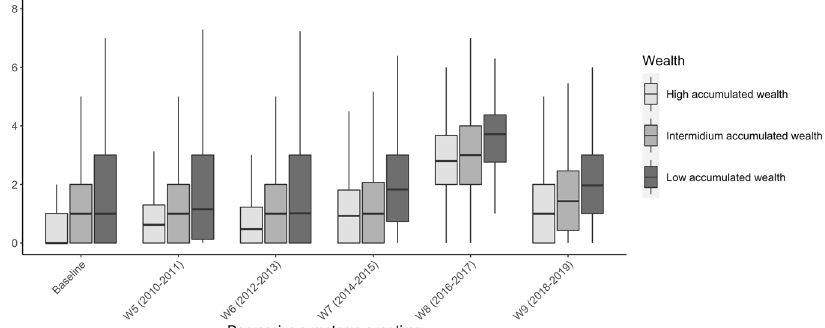
Fig. 2 The average distribution of depressive symptoms across all waves of data collection over the 14-year follow-up strati fi ed by wealth at baseline. W5-W9 symbols stand for the wave number of the follow-up.